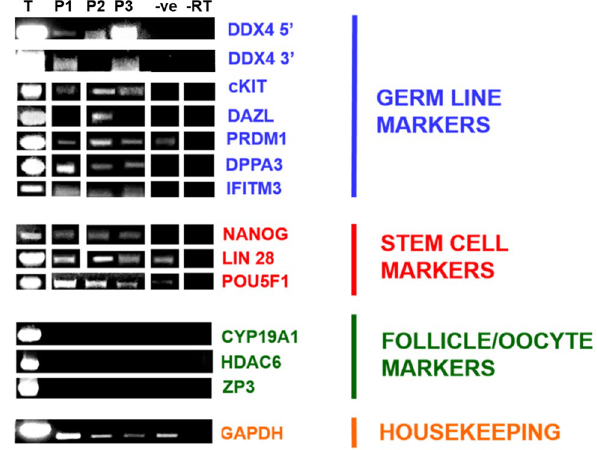
Figure 4. RT-PCR of stem cell and germline markers in DDX4 positive and negative sorted cells. Template DNA complimentary to primers was used as a positive control (T). Expression analysis of germline (blue -DDX4 5 ′ and 3 ′ , cKIT, DAZL, PRDM1, DPPA3 and IFITM3), stem (red-NANOG, LIN28 and POU5F1) and oocyte markers (green-CYP19A1, HDAC6 and ZP3) in sub-populations (P1, P2 and P3) of sorted human ovarian DDX4-positive and DDX4-negative cells ( − ve). GAPDH was an internal control (brown). Reverse transcriptase was omitted from duplicate reactions as negative controls ( − RT). Samples were derived from the same experiment and gels were processed in parallel. White spaces between bands indicate when 1) samples were not run adjacently on the same gel, 2) bands have been grouped from different gels and 3) different exposures have been used for clarity. Full-length gels can be seen in Supplementary Figures